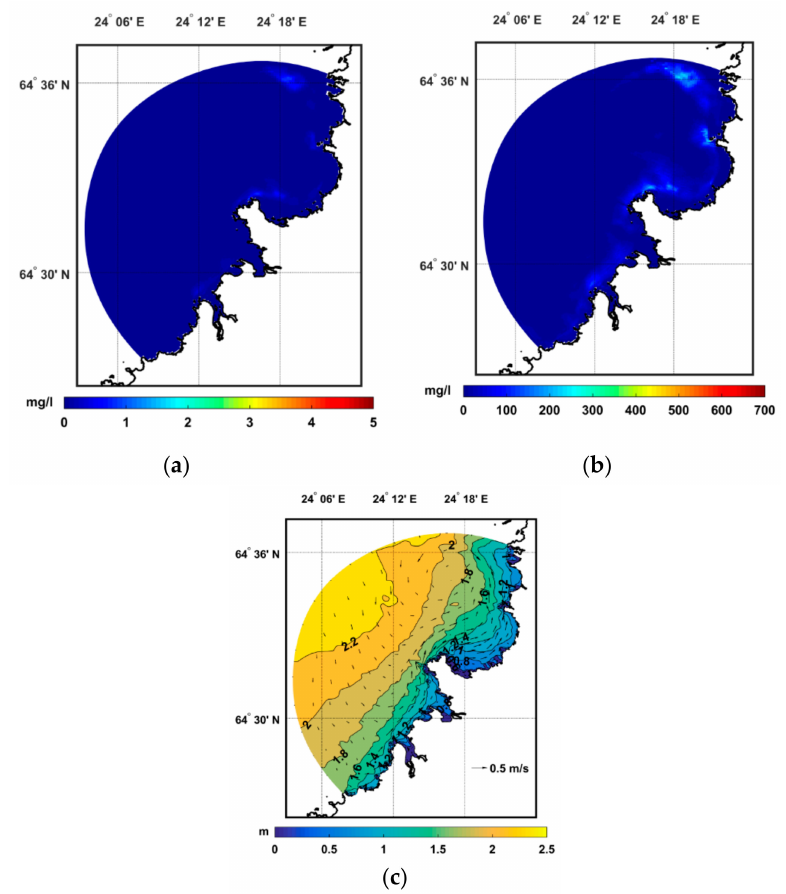
Figure 5. ( a ) Surface and ( b ) bottom SSC; ( c ) SWH and surface currents. Model results for 27 September 2014.